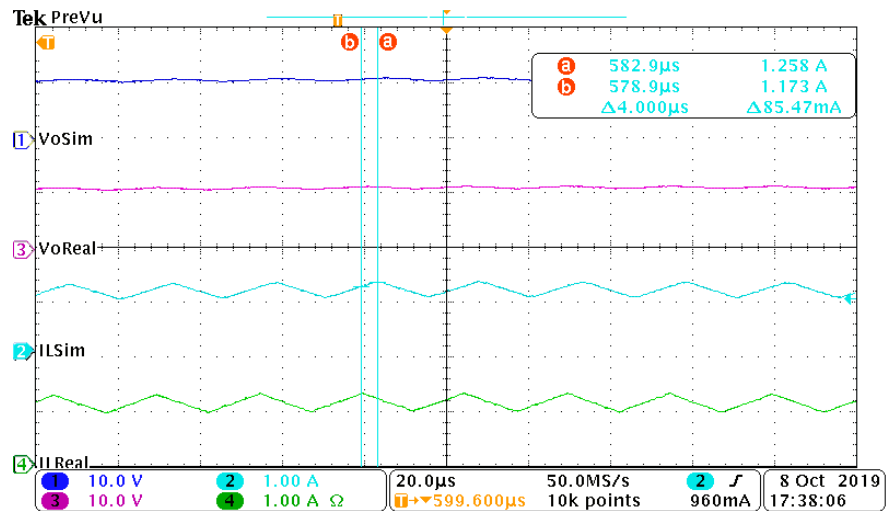
Figure 18. Output signals of the real converter and HIL simulation with a time delay, simulated voltage (Channel 1), simulated current (Channel 2), real voltage (Channel 3), and real current (Channel 4).